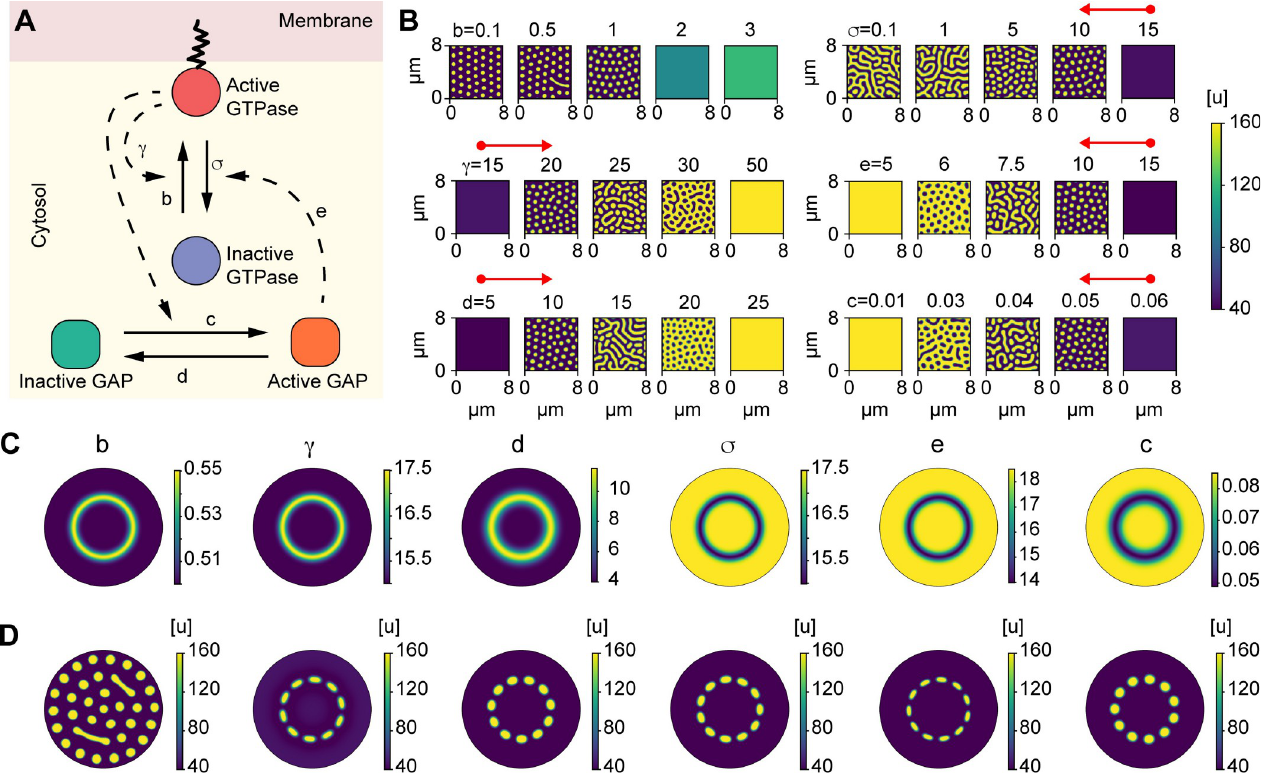
Fig 2. The WPGAP model generates rosettes of GTPase activity if a ring of an intermediate species is assumed. A) Schematic of the Wave-Pinning GTPase Activating Protein (WPGAP) model. B) WPGAP simulation results for individual parameter sweeps (Table 1). Red arrows show most parameters can transition from a low intensity homogenous regime (circle cap) to a spot patterning regime (arrow cap). C) Spatial profile of parameters modulated by species M. M either activates (first 3 panels) or inhibits (last 3 panels) parameters. D ) Active GTPase concentrations using the parameter profiles shown in C (above each panel, respectively). Consistent with parameter sweeps shown in B , each parameter is capable of being modulated to form a rosette pattern except for the basal activation rate b